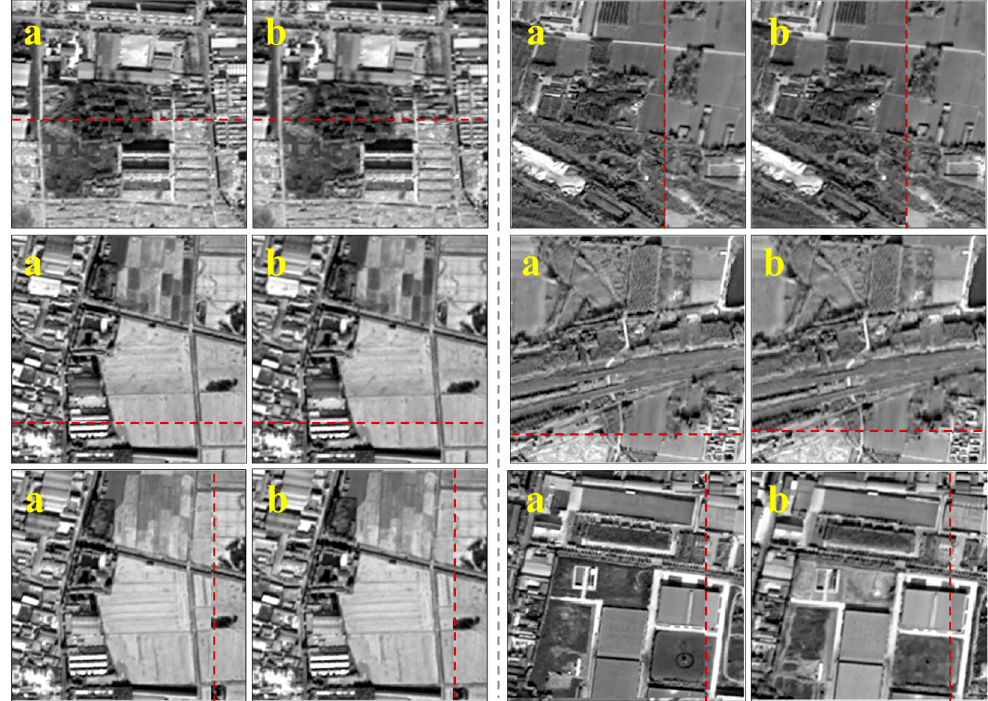
Figure 7. Examples of pre-registration ( a ) and post-registration ( b ) shown by Swipe Tool in ArcGIS. The red line is the dividing line of the bi-temporal images.